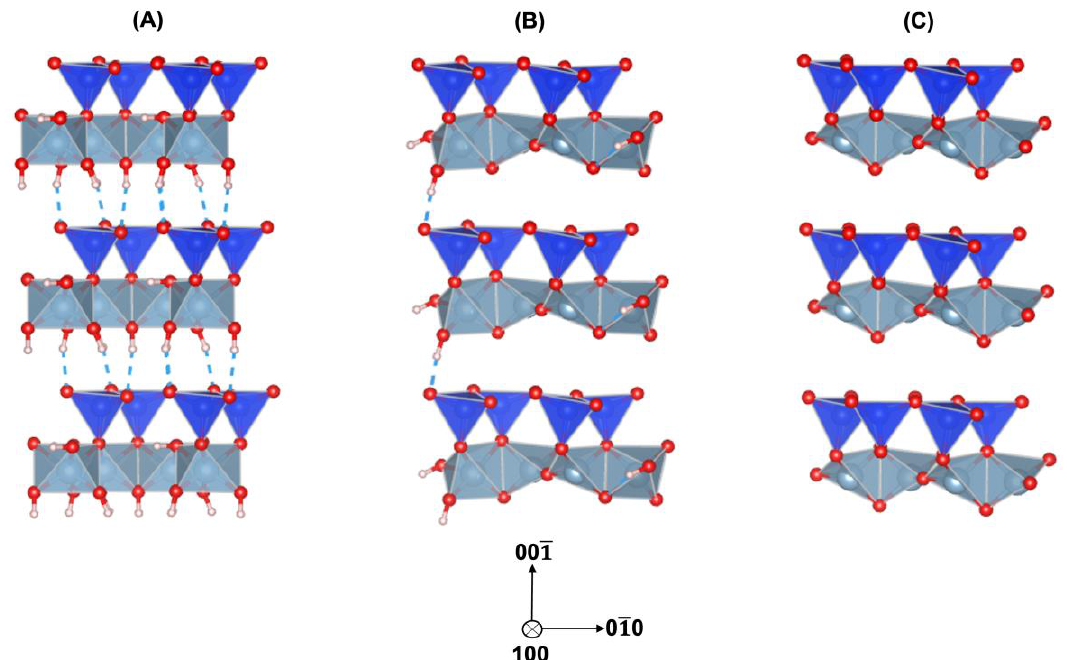
Figure 1. ( A ) The initial periodic 1 × 1 × 3 ideal kaolinite supercell, Al 12 Si 12 O 30 (OH) 24 . ( B ) Partially dehydroxylated ideal kaolinite, Al 12 Si 12 O 39 (OH) 6 . ( C ) Metakaolinite, Al 12 Si 12 O 42 . Silicate tetrahe- drons are depicted in dark blue, aluminate octahedrons in light blue, oxygen atoms in red, and protons in white.